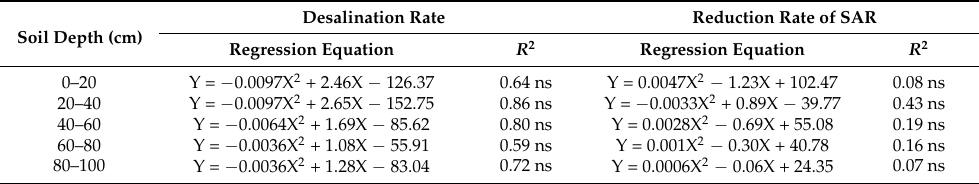
Table 5. The regression analysis results of soil desalination rate and reduction rate of sodium adsorption ratio at different soil depths with okra root weight density.